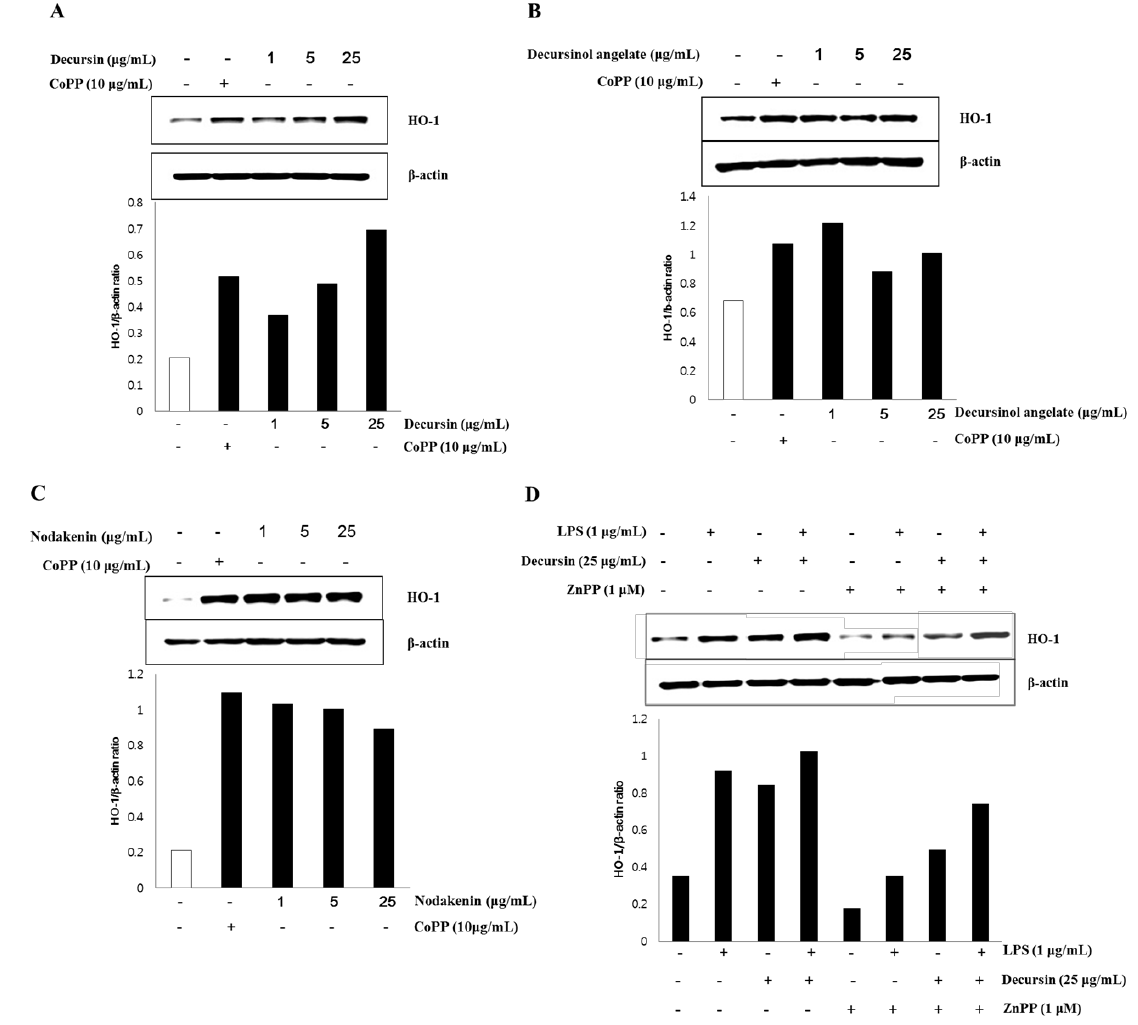
Figure 2. Effect of decursin, decursinol angelate, and nodakenin on HO-1